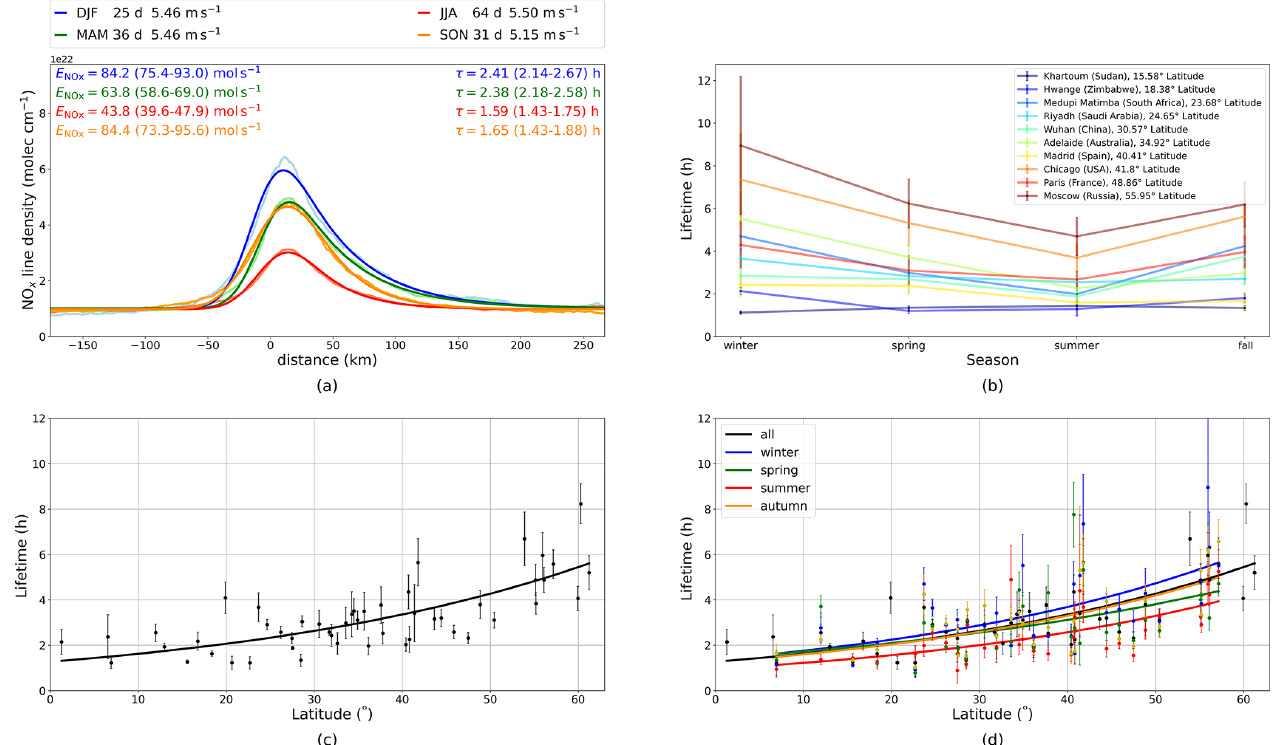
Figure 6. (a) The seasonal NO x line densities for the city of Madrid. The line densities are in light colors and the fit in dark colors. (b) Esti- mated lifetimes as a function of season for 10 source regions. (c) Estimated NO x lifetimes for the selected 50 sources as a function of latitude. (d) Estimated lifetimes in dependence on latitude (black) separated into winter (blue), spring (green), summer (red), and fall (yellow). All plots are based on TROPOMI NO 2 data from 1 March 2018 to 29 February 2020. Sources from the Southern Hemisphere are mirrored in latitude and season. Given uncertainties and error bars are the standard deviation derived by the EMG fitting